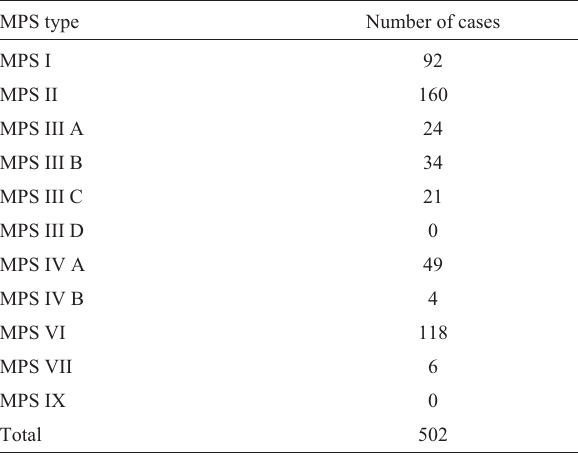
Table 2 - Diagnosis of new cases of MPS by the MPS BRAZIL NETWORK among 2,606 patients investigated between 2004 and 2011 (8